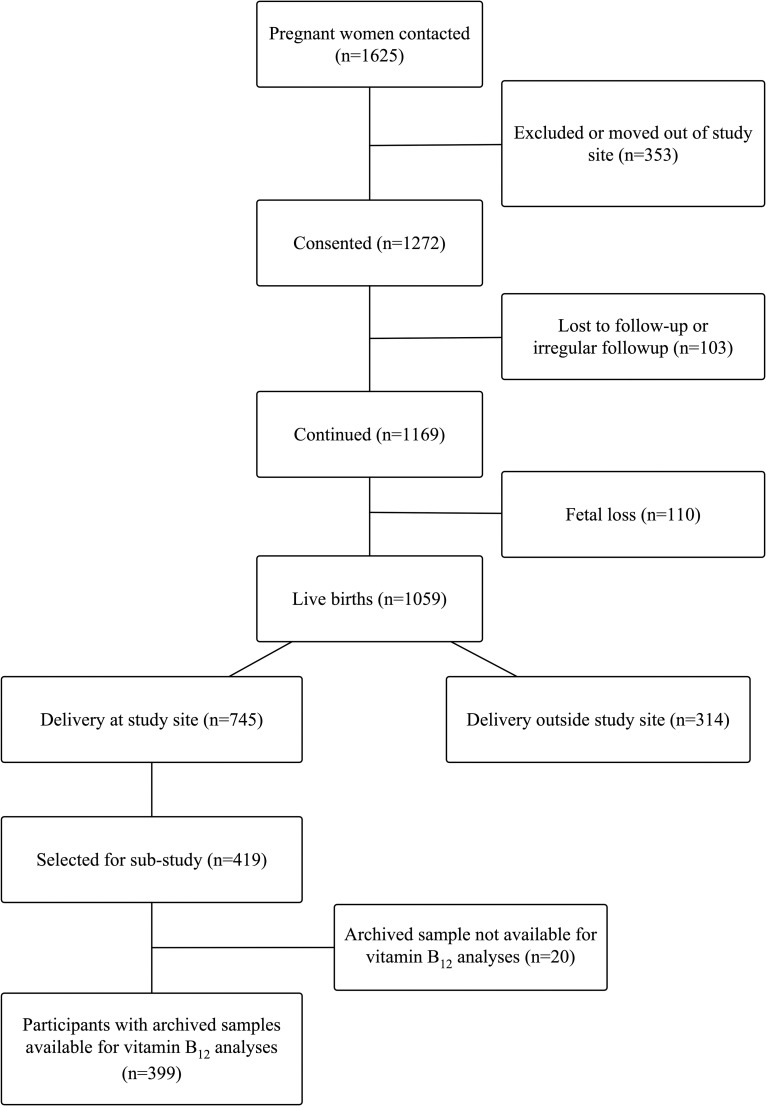
Participant flow chart.